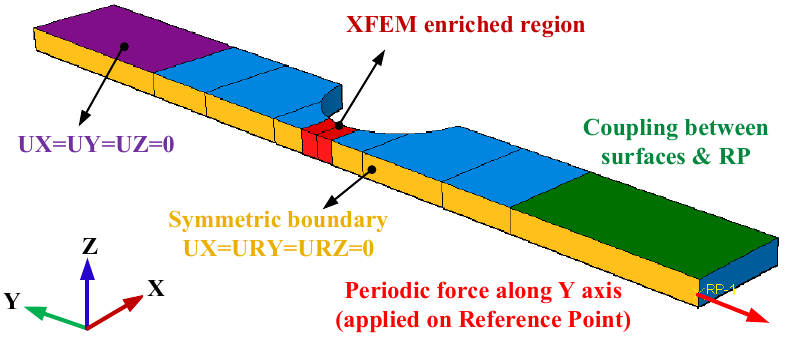
Figure 7. Numerical model.